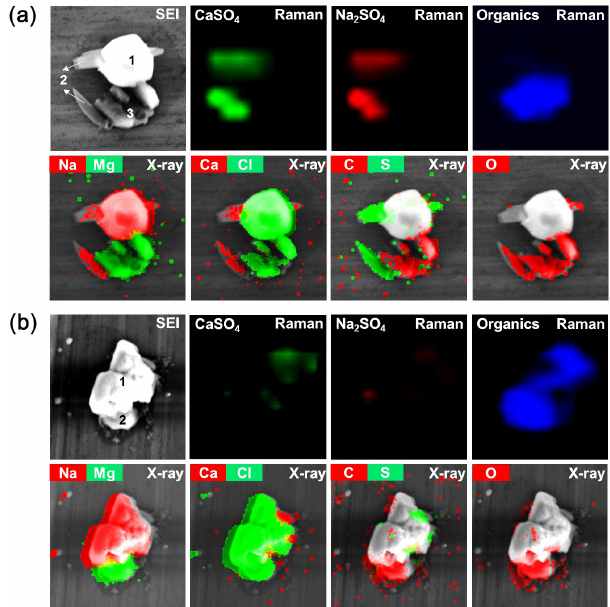
Figure 2. Secondary electron, molecular Raman map and elemental X-ray map (overlaid on SEIs) images of two typical (a) summertime and (b) wintertime